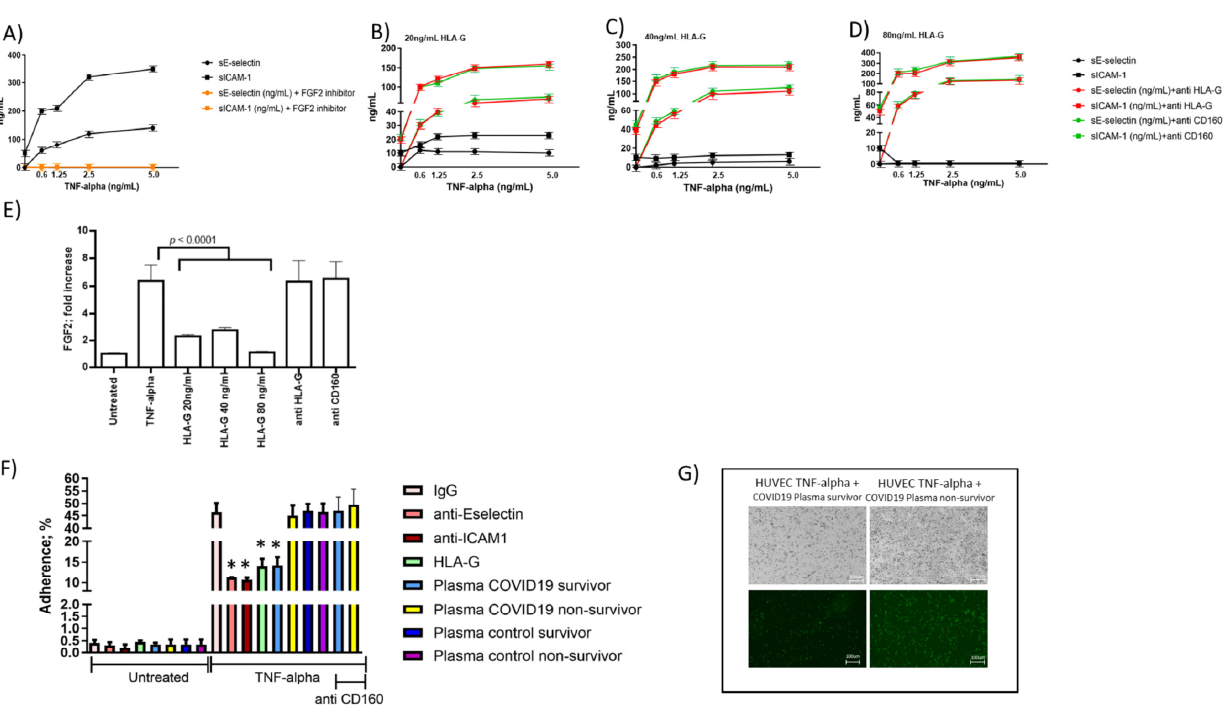
Figure 3. Endothelial cell in vitro assays. HUVEC endothelial cells were treated with TNF-alpha (0.625, 1.25, 2.5, 5.0 ng/mL) for 4 h and cultured overnight. ( A ) The levels of sICAM and sE-Selectin were assessed in culture supernatants in the absence or presence of FGF2 inhibitor. HUVEC endothelial cells were treated with TNF-alpha (0.625, 1.25, 2.5, 5.0 ng/mL) for 4 h and treated overnight with HLA-G molecules (20, 40, 80 ng/mL). ( B – D ) The levels of sICAM and sE-Selectin were assessed in culture supernatants in the absence or presence of anti-HLA-G (10 ng/mL) or anti-CD160 (20 ng/mL) antibodies. ( E ) Fold increase expression of FGF2 in TNF-alpha (2.5 ng/mL) activated HUVEC in the presence of HLA-G or anti-HLA-G, anti-CD160 antibodies in comparison with untreated HUVEC. ( F ) HUVEC endothelial cells were treated with TNF-alpha (2.5 ng/mL) for 4 h and cultured overnight in the presence of anti-E-Selectin (20 ng/mL), anti-ICAM1 (10 ng/mL), HLA-G molecule (40 ng/mL), and plasma samples (100 µ L) from survivor and non-survivor patients in the absence (untreated) or presence of TNF-alpha treatment (2.5 ng/mL). The cells were then co-cultured with peripheral blood neutrophils from non-COVID-19 healthy controls and analyzed for neutrophil cells adhesion. anti-CD160 (10 ng/mL) was used to confirm the effect of interaction between plasmatic sHLA-G and CD160 in controlling neutrophil cells adhesion. A control IgG was used. * p < 0.05; Student’s t -test. ( G ) Images of BioTracker 488 Green Nuclear Dye-labeled neutrophils bound to untreated and TNF α -treated HUVEC monolayers incubated with plasma sample (100 µ L) from survivor (left panel) and non-survivor (right panel)